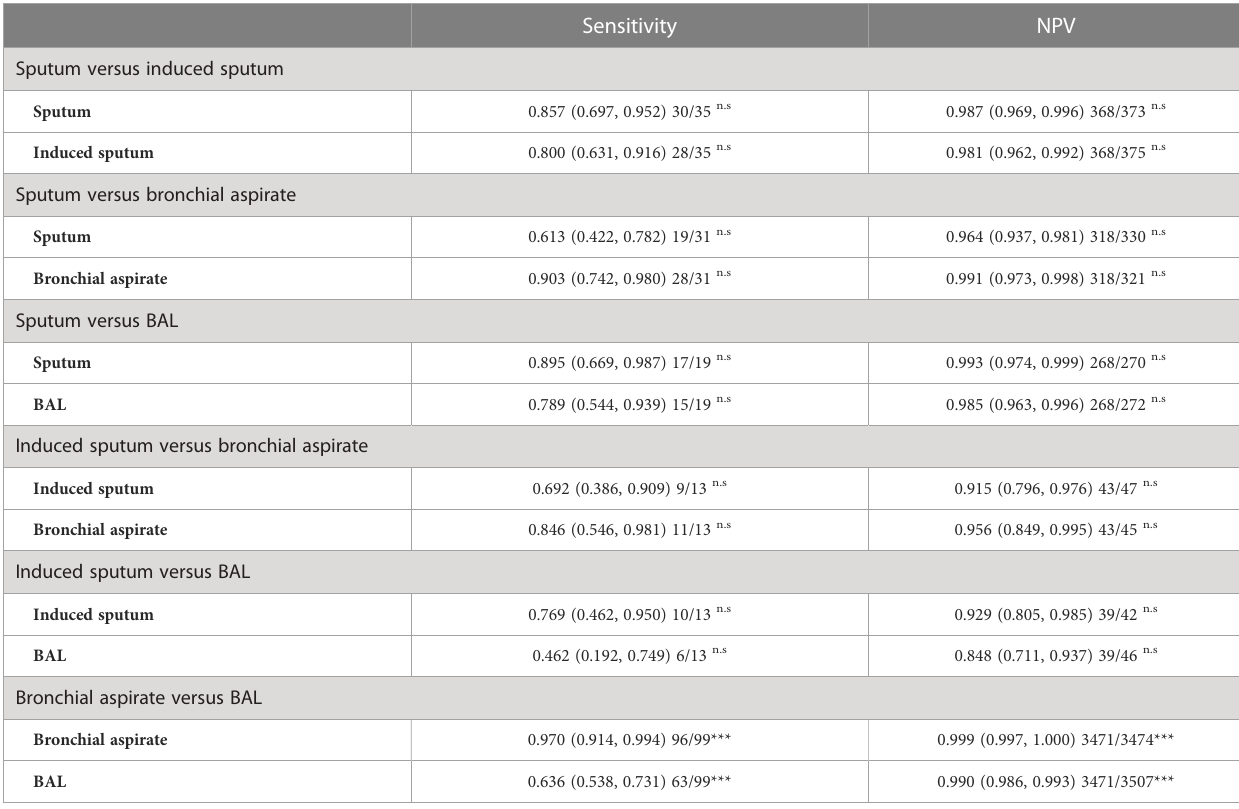
TABLE 6 Sensitivity of culture to predict tuberculosis according to the type of specimen using a 72-hours pairing window within the same patient.